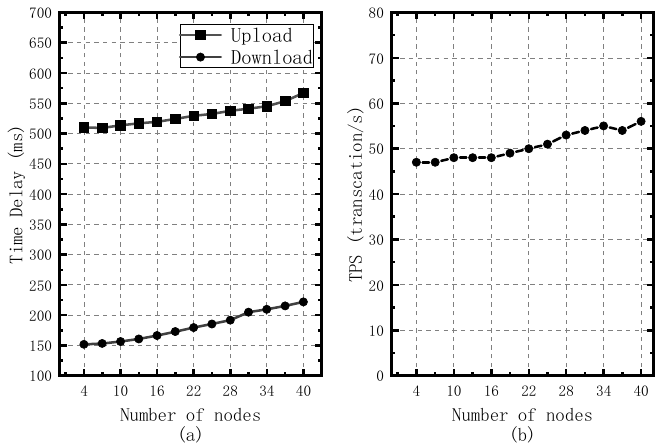
Figure 9. ( a ) Cost of transaction ( b )